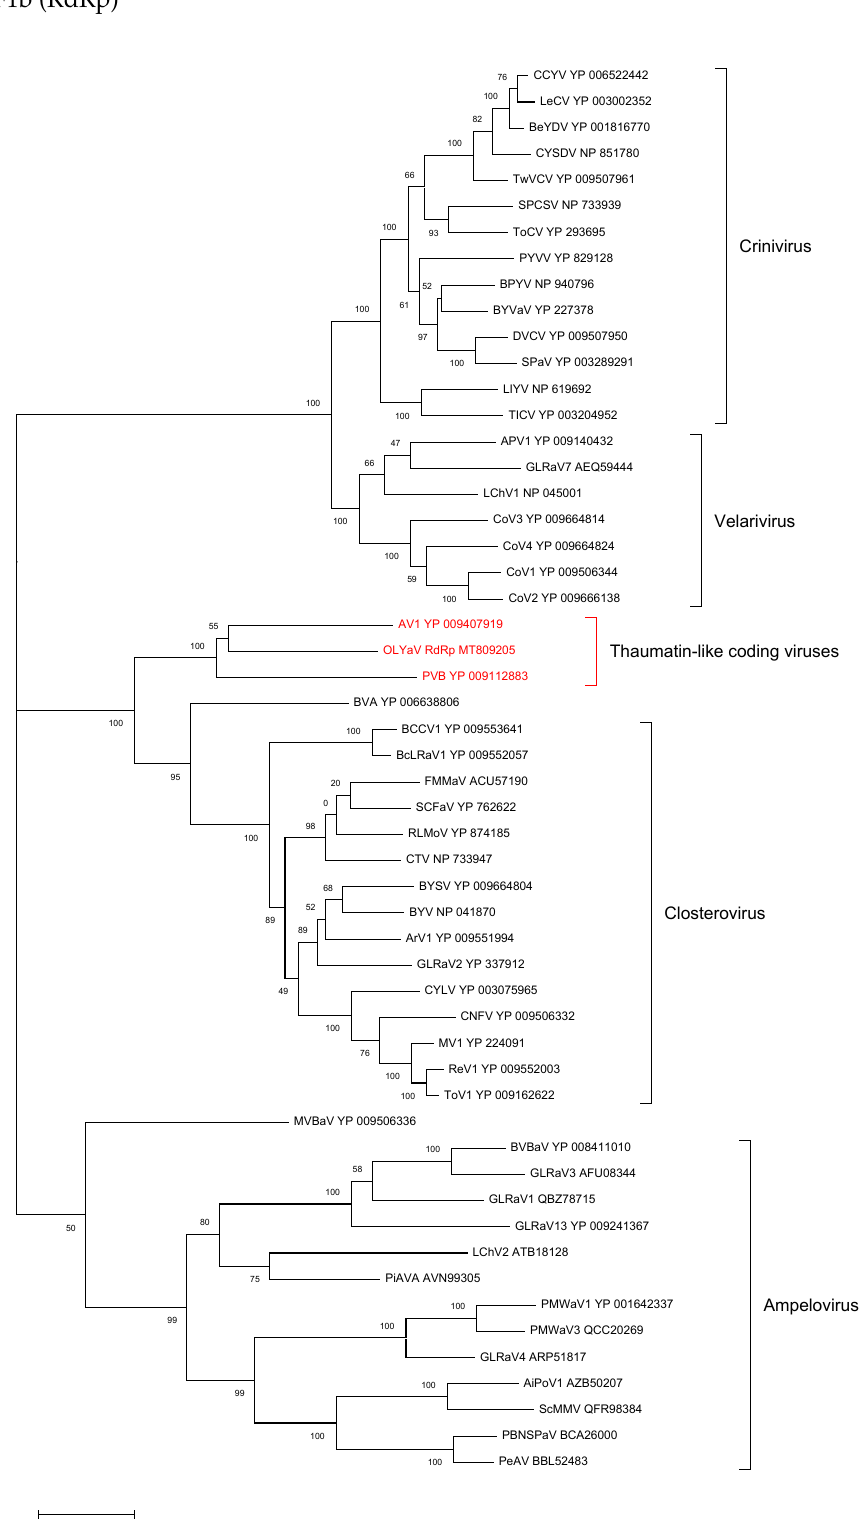
Figure 7. Maximum likelihood phylogenetic tree using the best substitution model by MEGA X of RdRp from representative members of the family Closteroviridae . Proteins of the isolates are identified by their protein_id number. The scale bar shows the genetic distance. Bootstrap percentages (500 re-samples) are indicated on the branches.